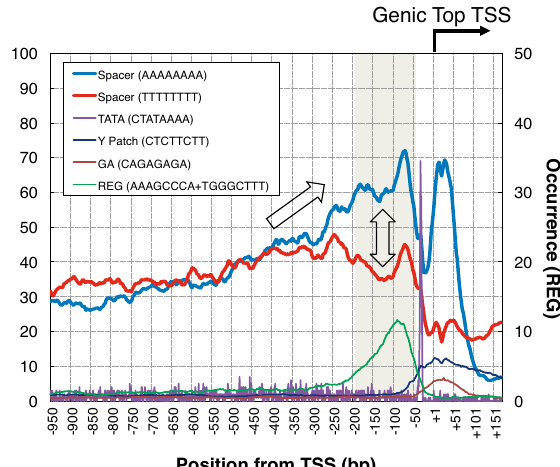
Figure 1. Distribution profiles of several promoter constituents. Occurrence of the octamers (Spacer, TATA, Y Patch, GA, and REG) according to the promoter position. Spacers are defined as octamers highly present in the promoter region and not core elements (TATA, GA, CA, or Y Patch) or REG. REG means Regulatory Element Group, and is identified according to its localization profile (LDSS) in the promoter region. Data of promoters for 21,673 protein-coding genes of Arabidopsis was summed and subjected to smoothing with a bin of 51 bp width except for the TATA